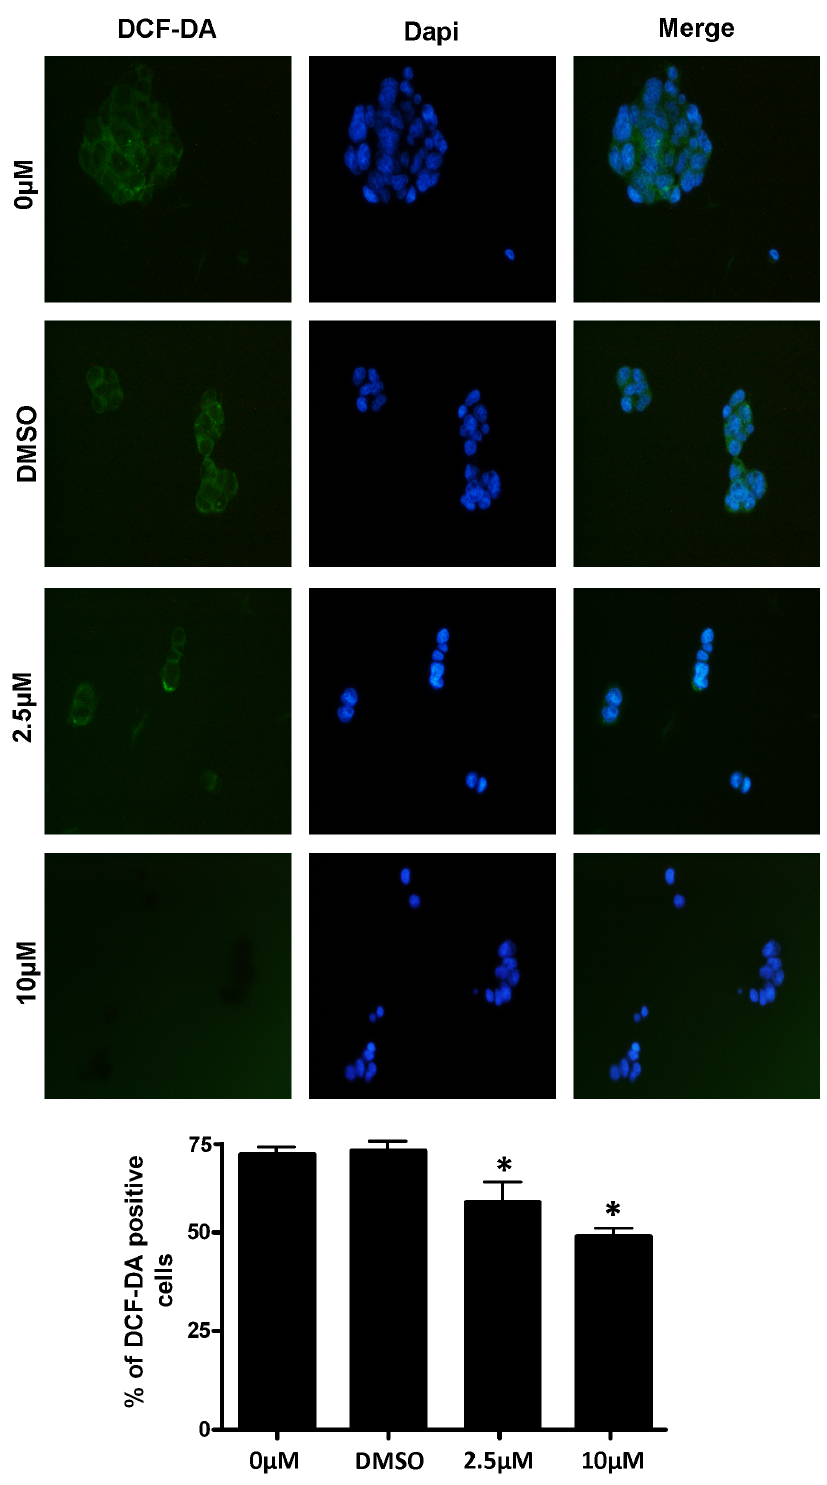
Figure 4. Measurement of intracellular ROS levels in RSV-treated PC12 cells under hypoxic conditions. Post-hypoxia and RSV treatment: the harvested PC12 cells were stained by CM-H2DCFDA to stain the intracellular ROS. DAPI was used to stain the nucleus. The images were obtained by a fluorescence microscope under low light conditions. The qualitative data of intracellular ROS in all concentration treatments of PC12 cells were captured through two different filters and a merged image was created. The lower panel contains the represented quantitative data, shown in the bar graph. Data were represented as means ± SD (* p < 0.05), of n = 3.